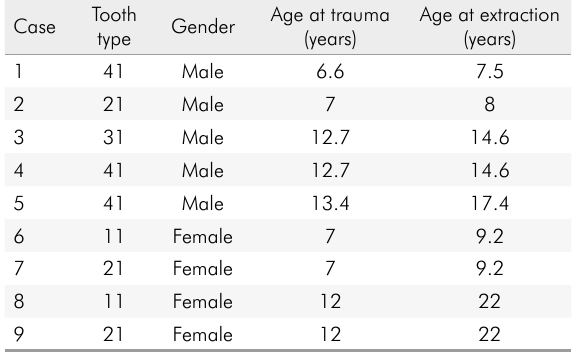
Table 1. Clinical data of subjects presenting with radiographic signs of